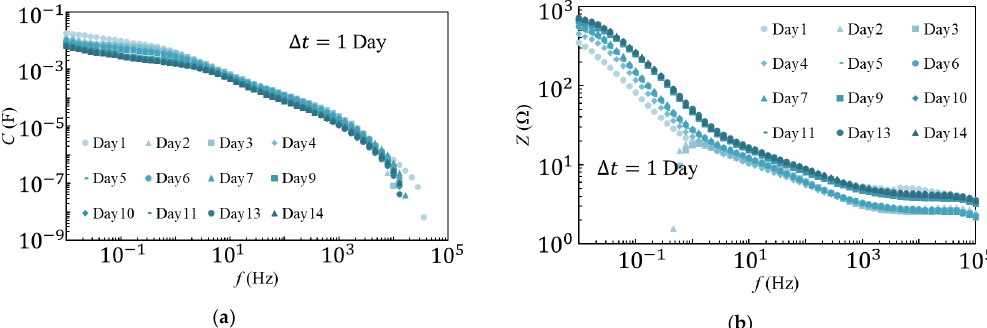
Figure 10. Measurement results of ( a ) C and ( b ) Z in the 25 °C degradation tests without discharge.